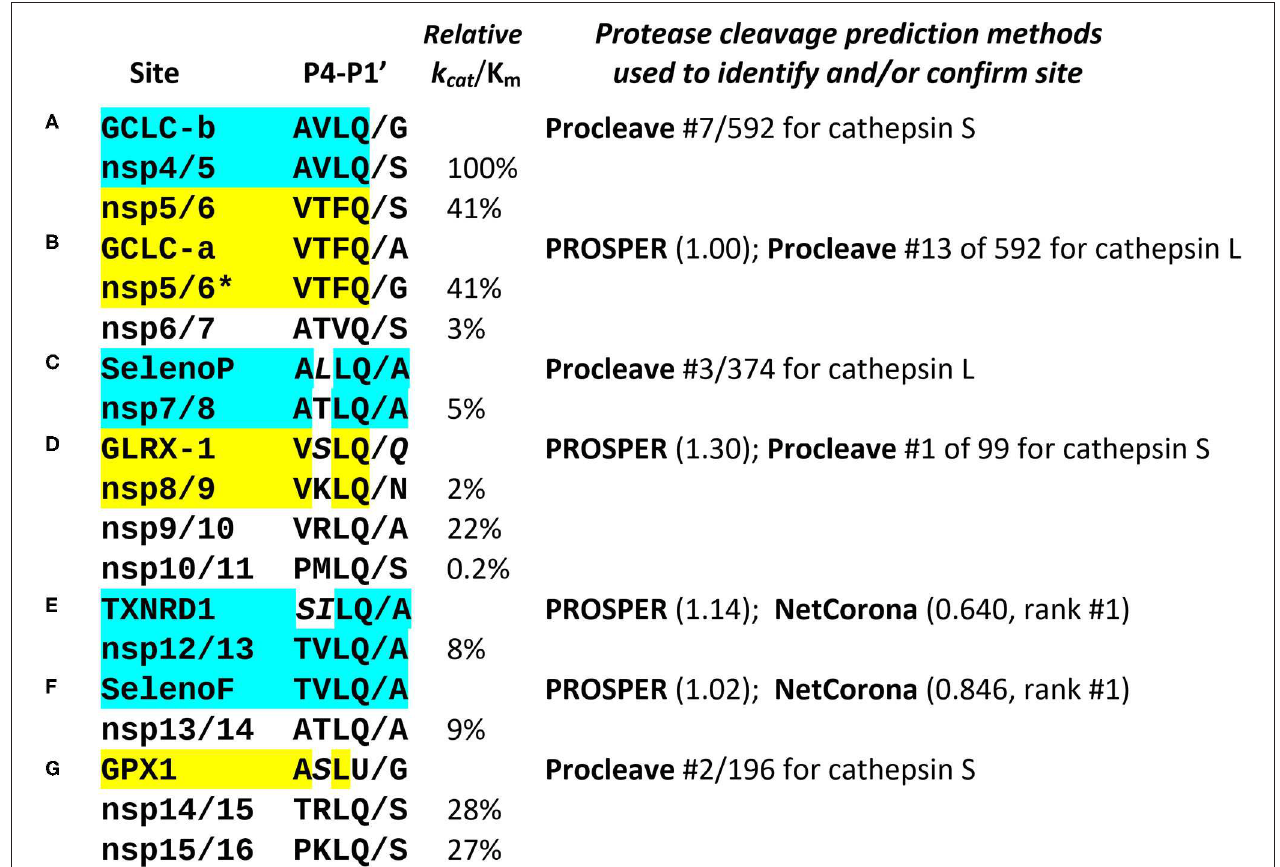
FIGURE 2 | Comparison of known and predicted M pro cleavage sites. The most relevant positions P4-P1 ′ of the 11 known SARS coronavirus M pro cleavage sites in non-structural proteins are shown (for nsp4 through nsp16), aligned with predicted sites in several human selenoproteins (GPX1, SelenoF, SelenoP, and TXNRD1), as well as glutaredoxin-1 (GLRX-1) and the rate-limiting enzyme for glutathione synthesis, glutamate-cysteine ligase catalytic subunit (GCLC, with 2 predicted cleavage sites A , B ). The known nsp cleavage sites shown are all from SARS-CoV-2, with the addition of the nsp5/6 site from SARS-CoV (marked*). The sites identified in human proteins are displayed next to the known M pro cleavage site to which they are most similar, highlighted in matching color. The experimentally determined catalytic efficiencies of SARS-CoV M pro at each of the known nsp cleavage sites are shown as relative k cat /K m ( 10). Three different methods for prediction of cysteine protease cleavage sites were used: PROSPER (11), with numbers in parenthesis showing the score for the predicted site, any score > 0.8 being significant; NetCorona (12), where scores > 0.5 are considered positive, and Procleave (13), where every possible P4-P4 ′ octamer in a protein sequence is evaluated, scored and ranked. Some aligned non-identical residues highlighted in italics are nonetheless chemically and structurally similar to residues found in the same position in the known cleavage sites, e.g., serine ( S ) vs. threonine (T), Leucine ( L ) or isoleucine ( I ) vs. valine (V), and glutamine ( Q ) vs. asparagine (N); all of these pairs differ only by a single carbon atom (CH 3 or CH 2 unit). The predicted M pro cleavage sites in human proteins labeled (A–G) are discussed in the text. The computational results cited are collated in Figure S2